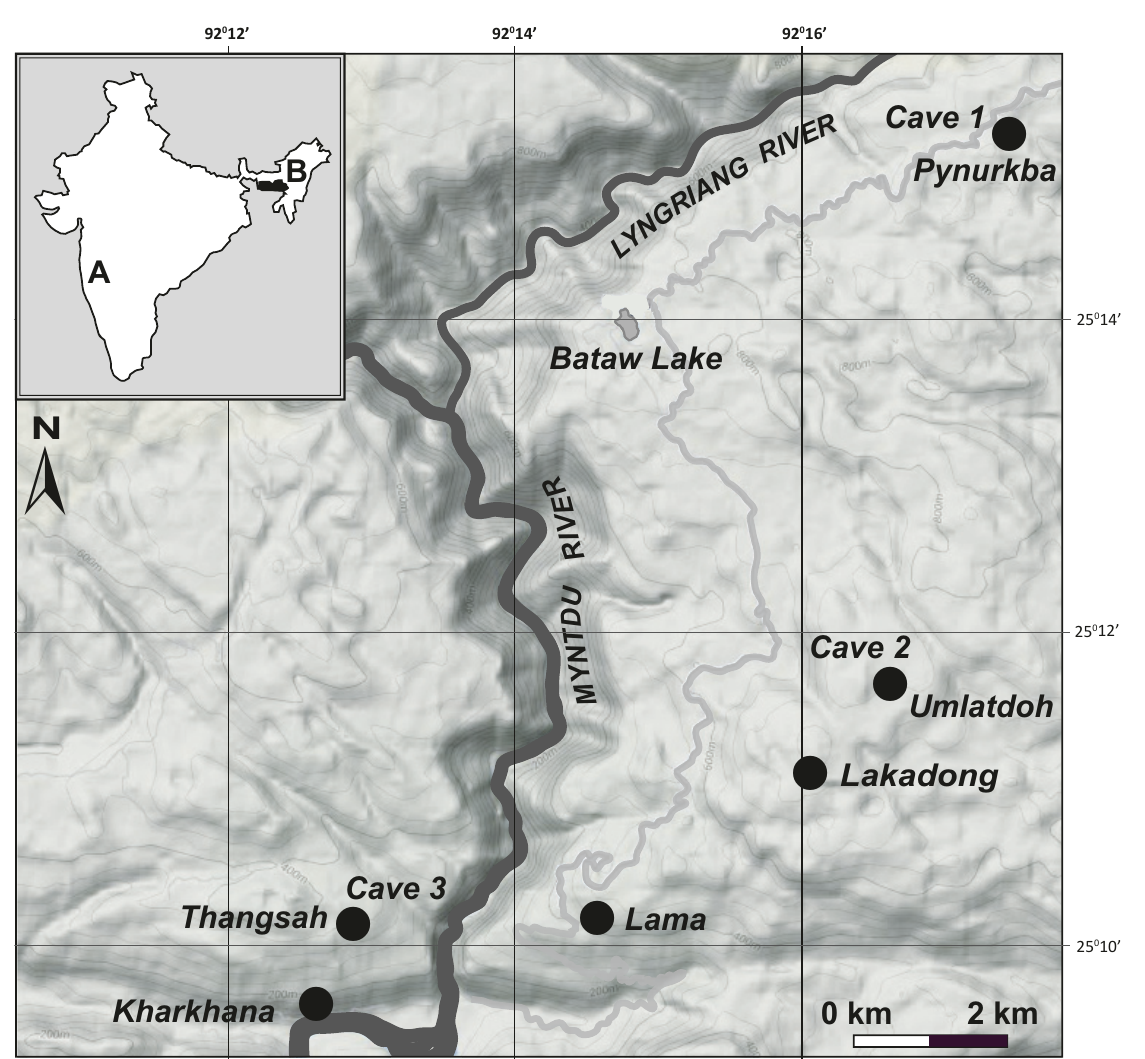
Figure 1. Location of the three new roosts of Otomops wroughtoni found in 2014 in the SE Jaintia Hills, in the oriental parts of Meghalaya. The inset is a general map of India showing the location of the historic roost at Karnataka, in the Western Ghats (A), and highlights the province of Meghalaya